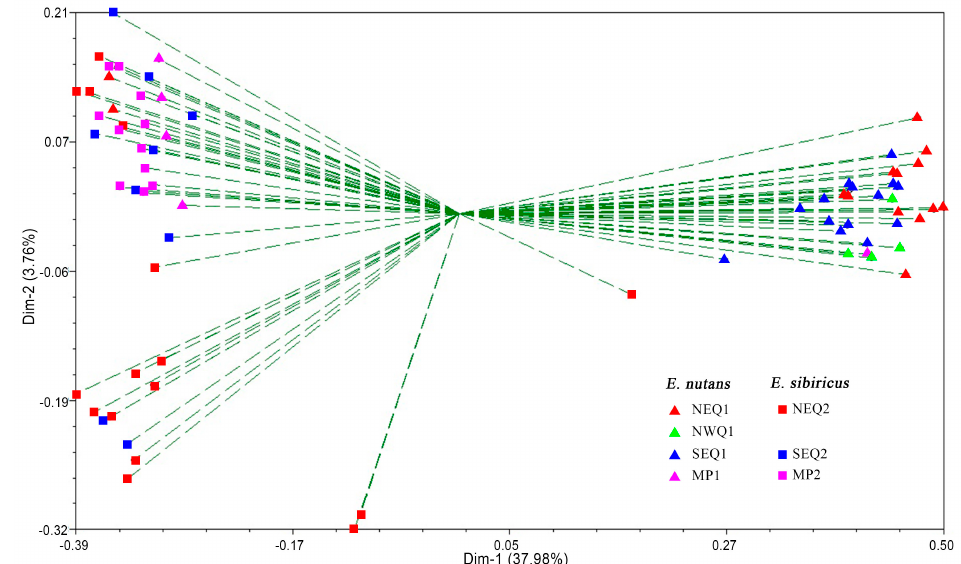
Figure 3. Principal coordinates analysis (PCoA) for the first and second coordinates estimated for EST-SSR markers using Jaccard’s genetic similarity matrix for seven groups of Elymus accessions. Different groups were distinguished by different colors and shapes. Red triangle: NEQ1; green triangle: NWQ1; blue triangle: SEQ1; pink triangle: MP1; red square: NEQ2; blue square: SEQ2; pink square: MP2.